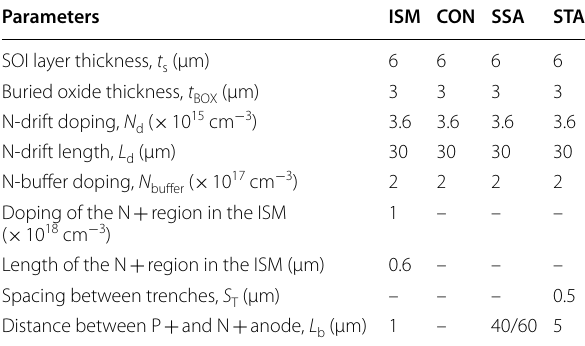
Table 1 Key Parameters for LIGBTs